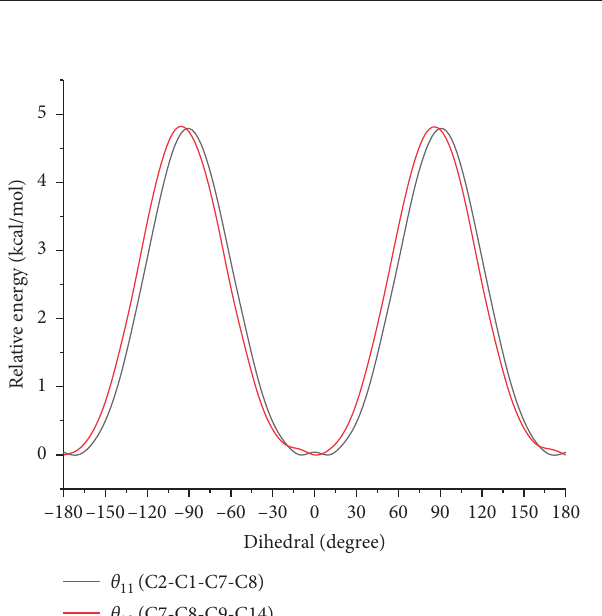
Figure 2: The potential energy curves versus the dihedral angles θ B3LYP/6-31 +G(d) level of theory.